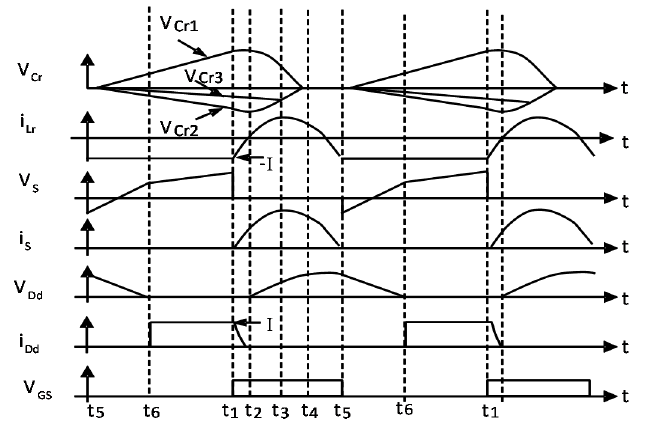
Figure 15. Main ideal waveforms of the converter under